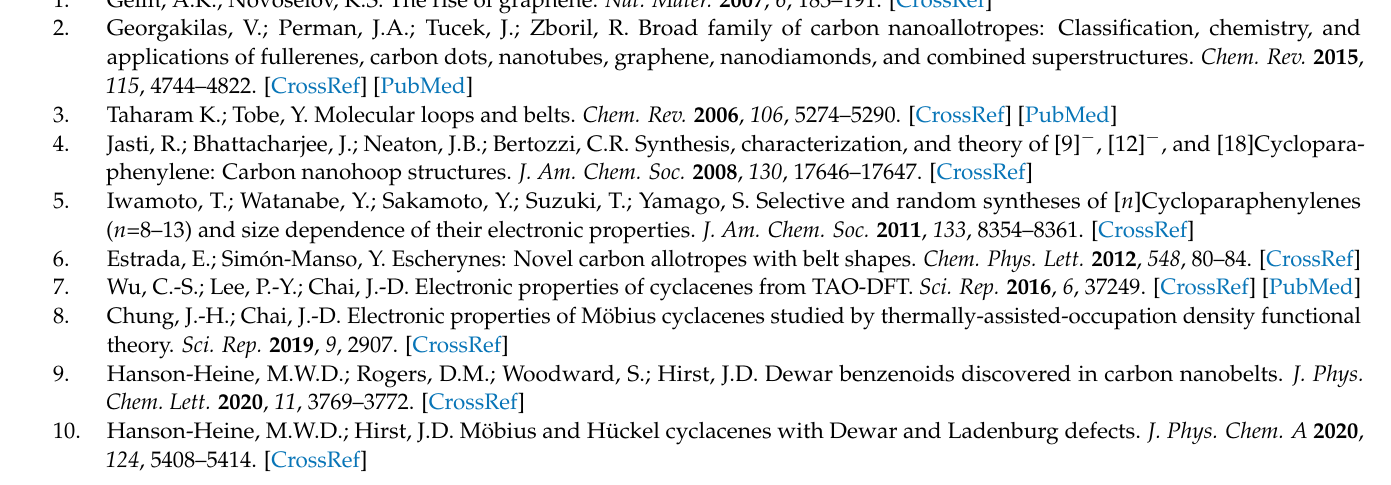
Figure S2: Visualization of active TAO-orbitals, such as H − 2 (1.796), H − 1 (1.308), H (1.308), L (0.670), L+1 (0.670), and L+2 (0.249), of ground-state C-Belt[12] at an isovalue of 0.02 e/Å 3 , computed using spin-restricted TAO-LDA. Numbers in parentheses show the TOONs, Figure S3: Visualization of active TAO-orbitals, such as H − 2 (1.588), H − 1 (1.397), H (1.397), L (0.636), L+1 (0.636), and L+2 (0.373), of ground-state C-Belt[16] at an isovalue of 0.02 e/Å 3 , computed using spin-restricted TAO- LDA. Numbers in parentheses show the TOONs, Table S1: Singlet-triplet gap E ST (in kcal/mol) of C-Belt[ n ], computed using spin-unrestricted TAO-LDA, Table S2: Vertical ionization potential IP v (in eV), vertical electron affinity EA v (in eV), fundamental gap E g (in eV), and symmetrized